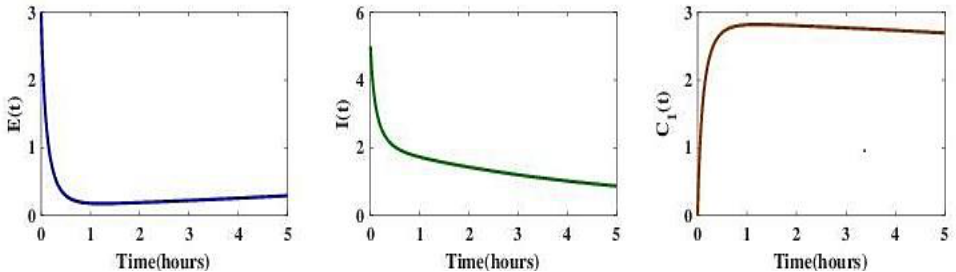
Figure 3. The nature of the curves of enzyme, protease inhibitor and complex 𝐶 = 3.0 µmol/L, 𝐼 = 5.0 µmol/L, 𝑆 = 0 µmol/L and 𝐶 0 0